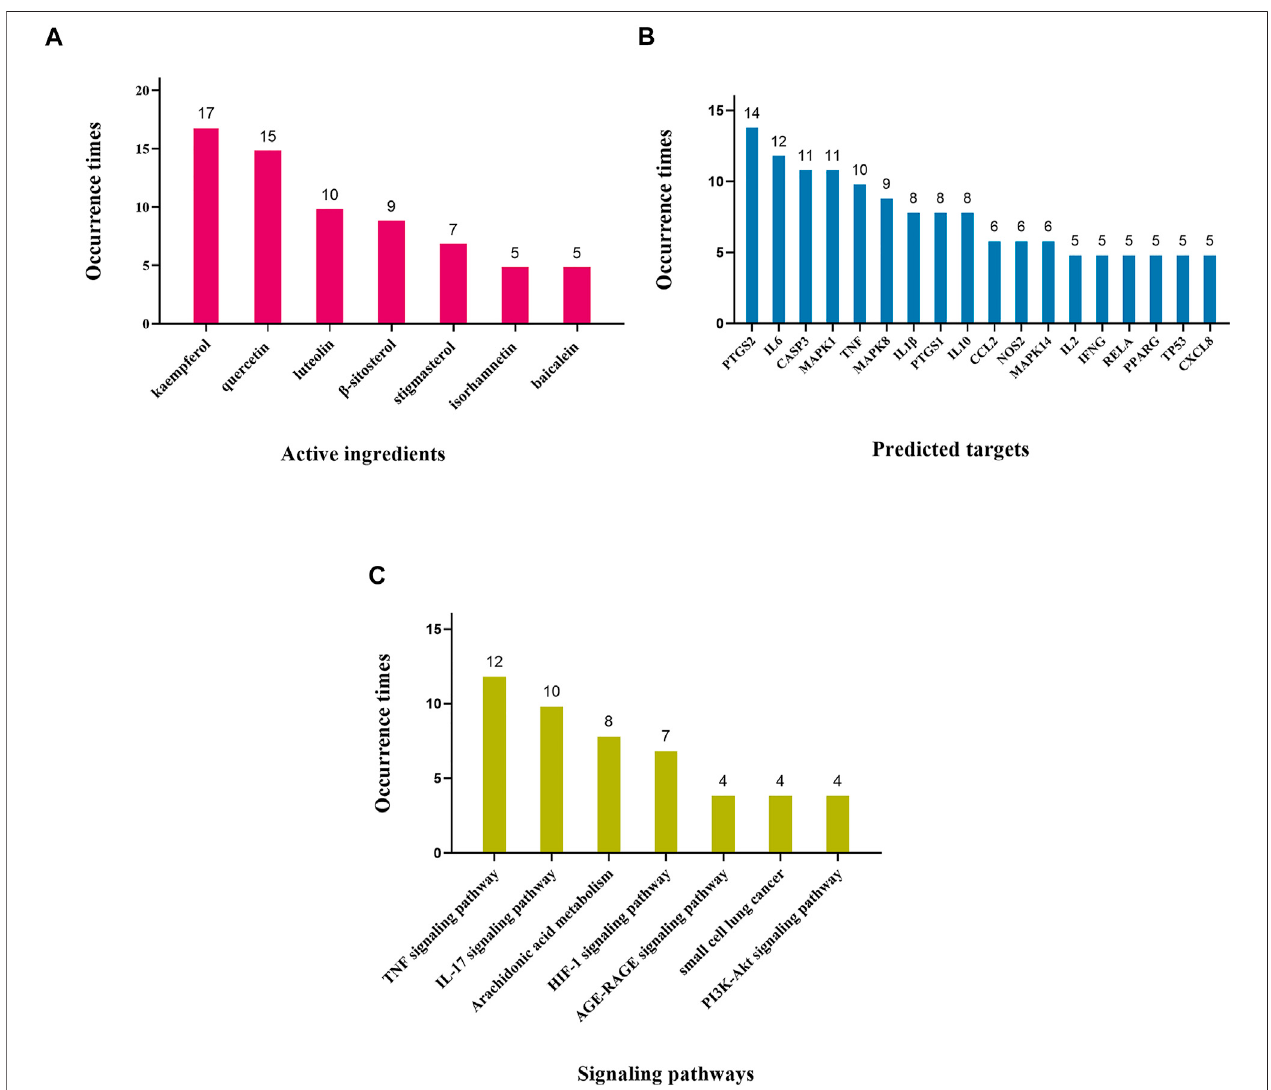
FIGURE4| Occurrence times ofpotential mechanism. Note: (A) Occurrence times ofactive ingredients(frequency ≥ 5). (B) Occurrence times ofpredicted targets (frequency ≥ 5). (C) Occurrence times of signaling pathways (frequency ≥ 4).